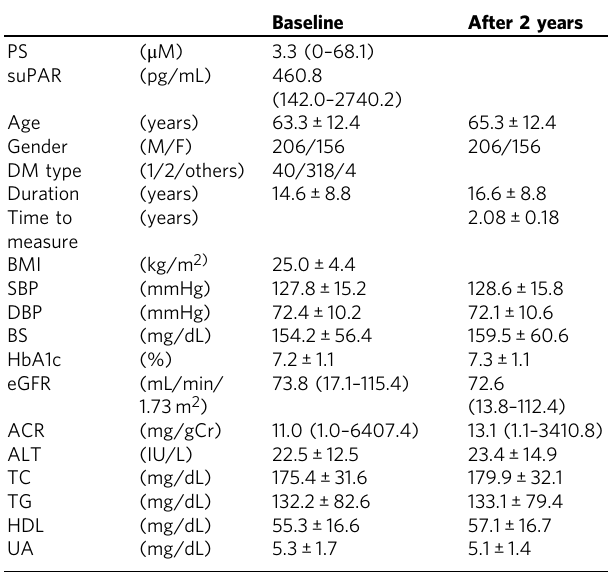
Table 1 Baseline and 2-year after characteristics of the U- CARE